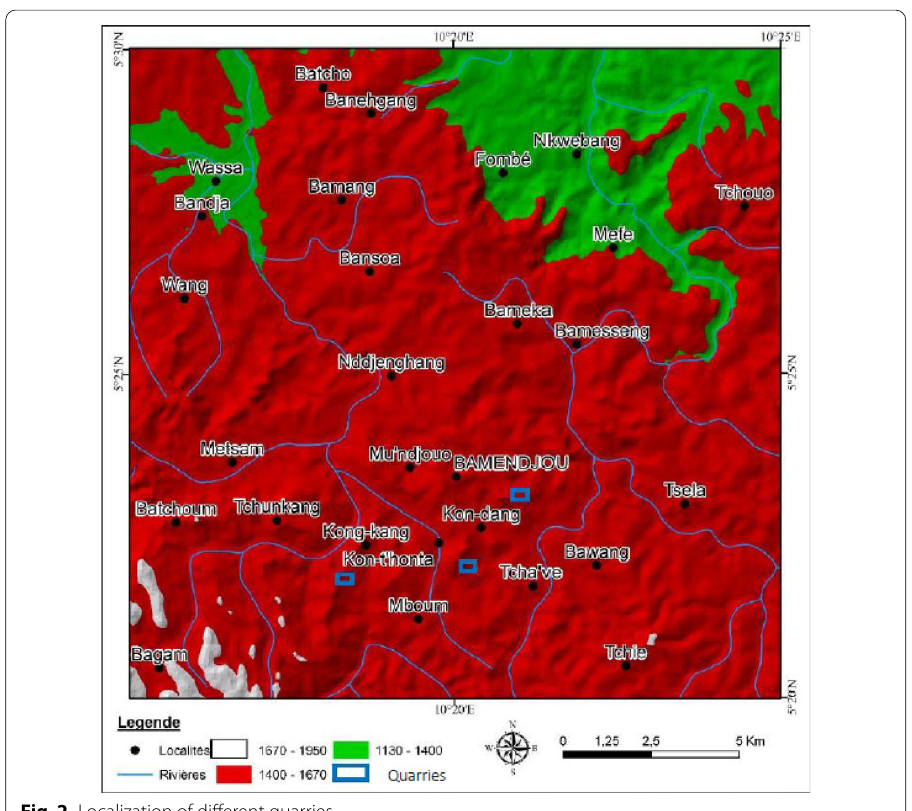
Fig. 2 Localization of different